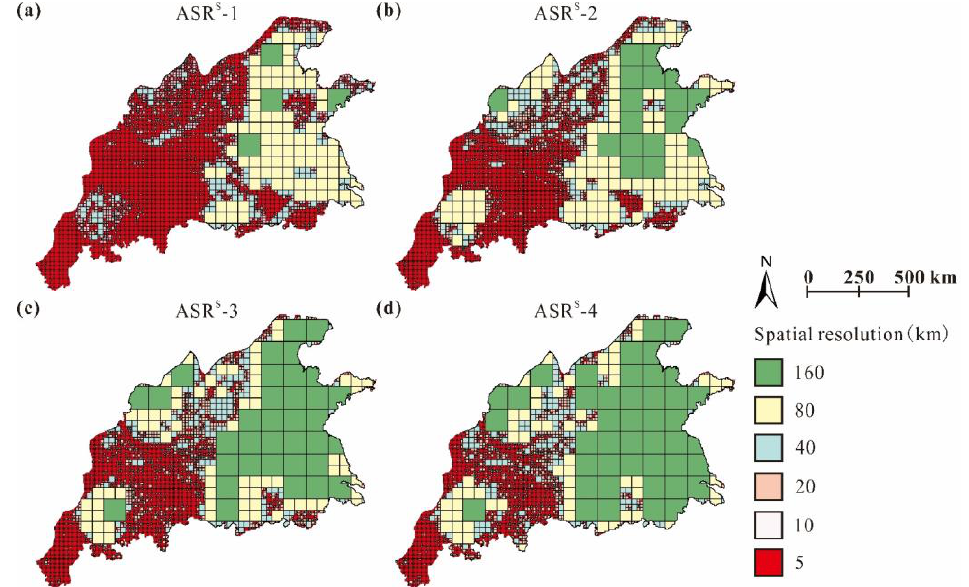
Figure 6. Appropriate spatial resolution of meteorological data for the regional potential productivity simulation based on the scale effect index: Appropriate spatial resolution ASR S -1 for the threshold of the scale effect index S of 100 kg ha − 1 year − 1 ( a ); appropriate spatial resolution ASR S -2 for the threshold of the scale effect index S of 200 kg ha − 1 year − 1 ( b ); appropriate spatial resolution ASR S -3 for the threshold of the scale effect index S of 300 kg ha − 1 year − 1 ( c ); and appropriate spatial resolution ASR S -4 for the threshold of the scale effect index S of 400 kg ha − 1 year − 1 ( d ).